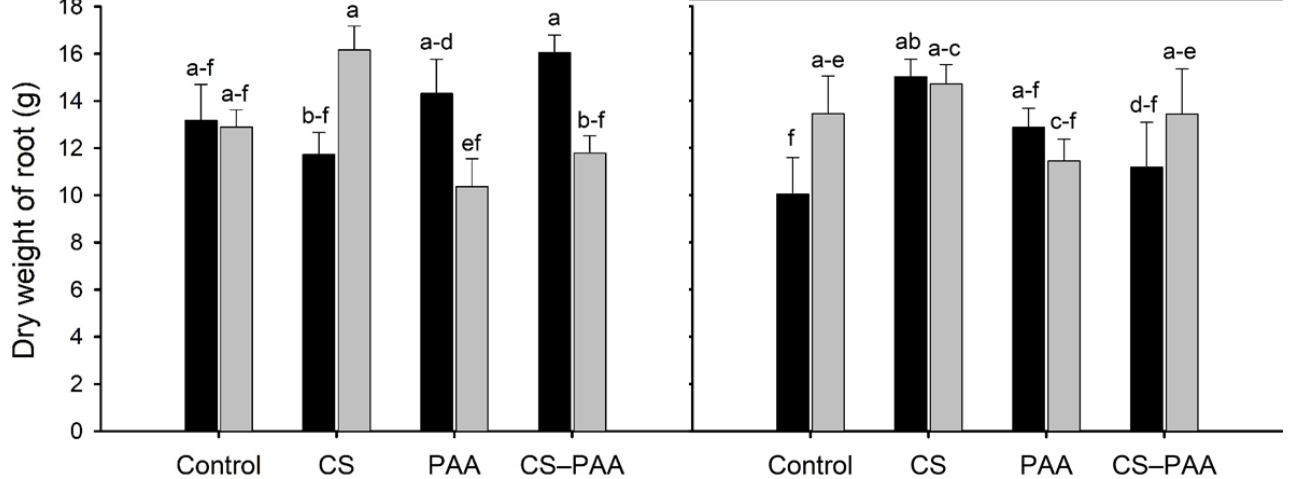
Figure 2. Effect of the interaction of the foliar applications (Control; CS = chitosan; PAA = poly(acrylic acid); and CS – PAA = chitosan – poly(acrylic acid) complexes); cultivars (black bars = Chichen Itza hybrid; grey bars = Jaguar variety) and nutrient solutions ( left = nutrient solution A; right = nutrient solution B) on root dry weight. Lower-case letters different between bars indicate significant difference according to Fisher’s LSD test ( p ≤ 0.05).